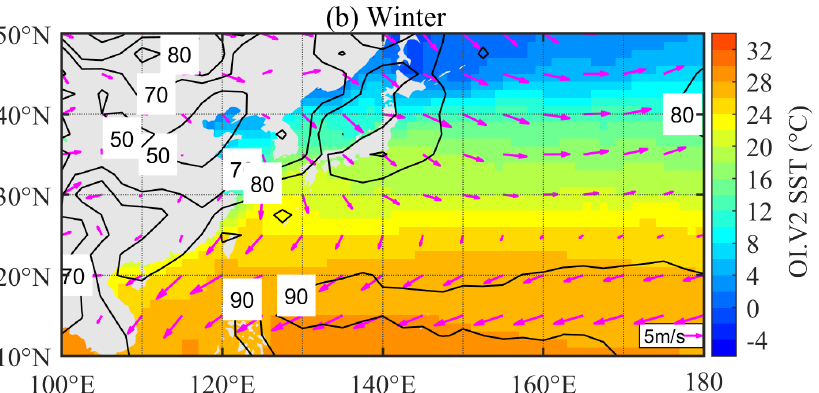
Figure 3. Seasonally averaged National Oceanic and Atmospheric Administration (NOAA) Optimum Interpolation version 2 (OI.V2) SST (color shading, unit: °C), near-surface wind (magenta vectors with the scale indicated at the bottom-right corner) and 925-hPa relative humidity field (black contours, unit: %) from the NCEP reanalysis-1 using the 3-year boreal ( a ) summer and ( b ) winter data.